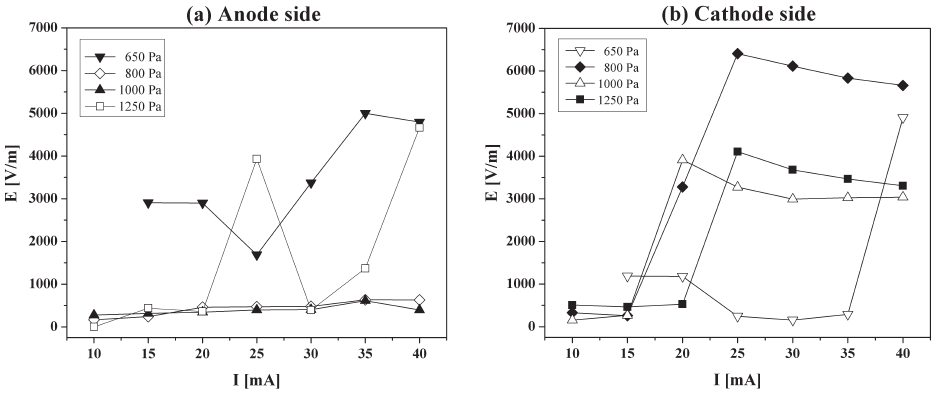
Figure 2: Axial electric field strength measured both on anode (a) and cathode (b) pairs of probes with respect to pressure and discharge current. Low-gradient T-form appeared for higher pressures and lower discharge currents. Values for p = 1250 Pa may be unreliable due to presence of